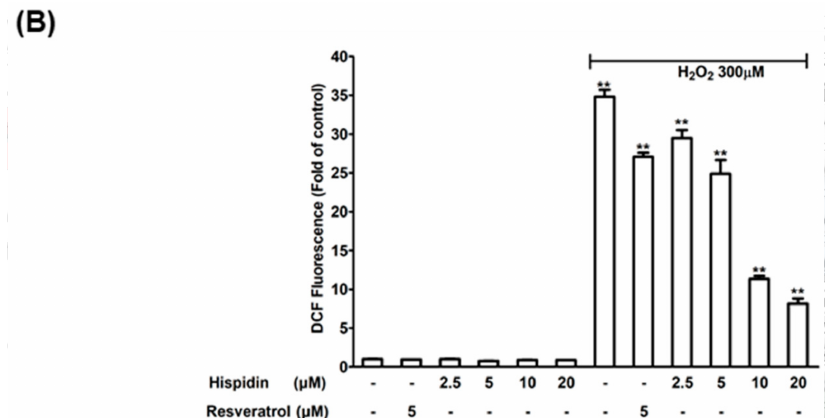
Figure 2. Protective e ff ect of hispidin against H 2 O 2 -induced oxidative stress on ARPE-19 cells. ( A ) ARPE-19 cells were pre-treated with various concentrations (2.5–20 µ M) of hispidin for 24 h and then treated with 300 µ M H 2 O 2 for 6 h. The H 2 O 2 -induced reactive oxygen species (ROS) generation was measured by dichlorofluorescin diacetate (DCFDA) assay. The green fluorescence represents the cells stained for ROS (magnification 200x); ( B ) Fluorescence was then measured with a multi-well fluorescence reader at 535 nm (emission). ** p < 0.01 versus vehicle